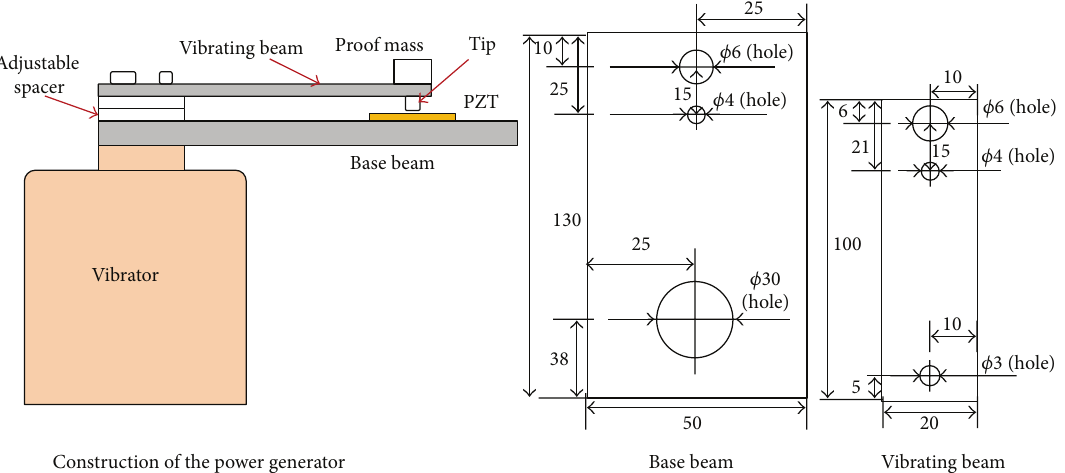
Figure 9: Construction of the power generator and schematics of the structures.